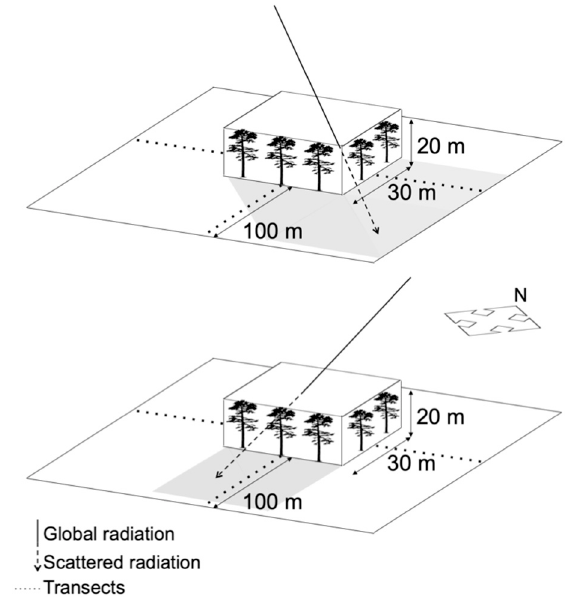
Figure 2. Sketch for two exemplary angles of penetrating solar irradiance, through the forest, in a virtual landscape and the shadows it casts. The drawn-through line represents the solar irradiance for Berlin, Germany (52.500 ◦ N, 13.405 ◦ E). The dashed line denotes the reduced solar irradiance (shadow). The dotted lines represent the directions of the transects for which crop yield was simulated.